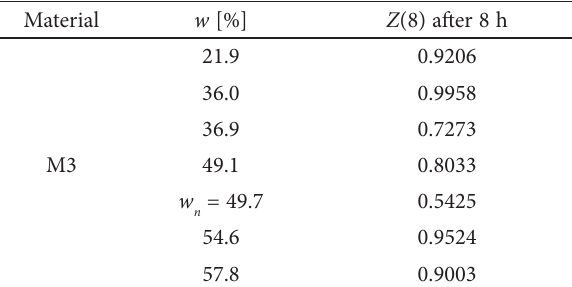
Table 6. Disintegration number Z (8) of material M3 Material